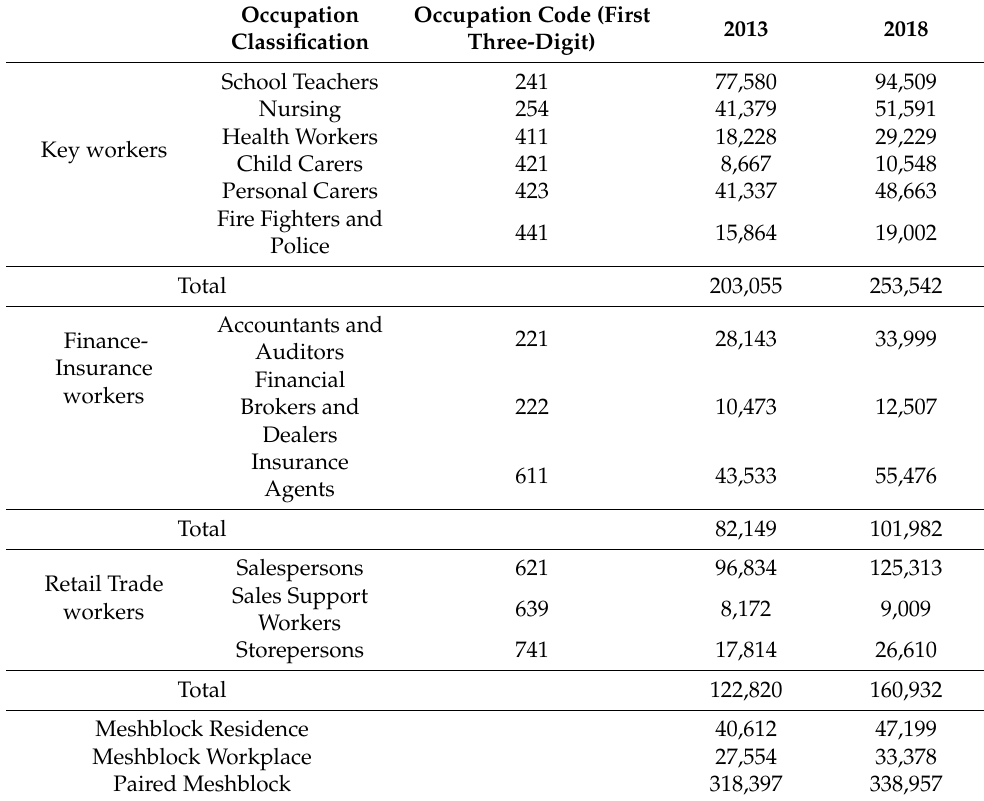
Figure 1. Distribution of meshblocks in Auckland in 2018. Table 1. Census sample